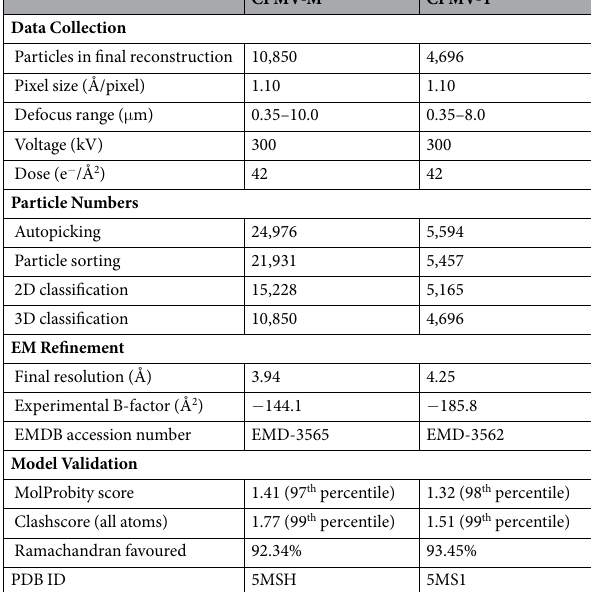
Table 1. Microscopy and image processing details for CPMV-M and